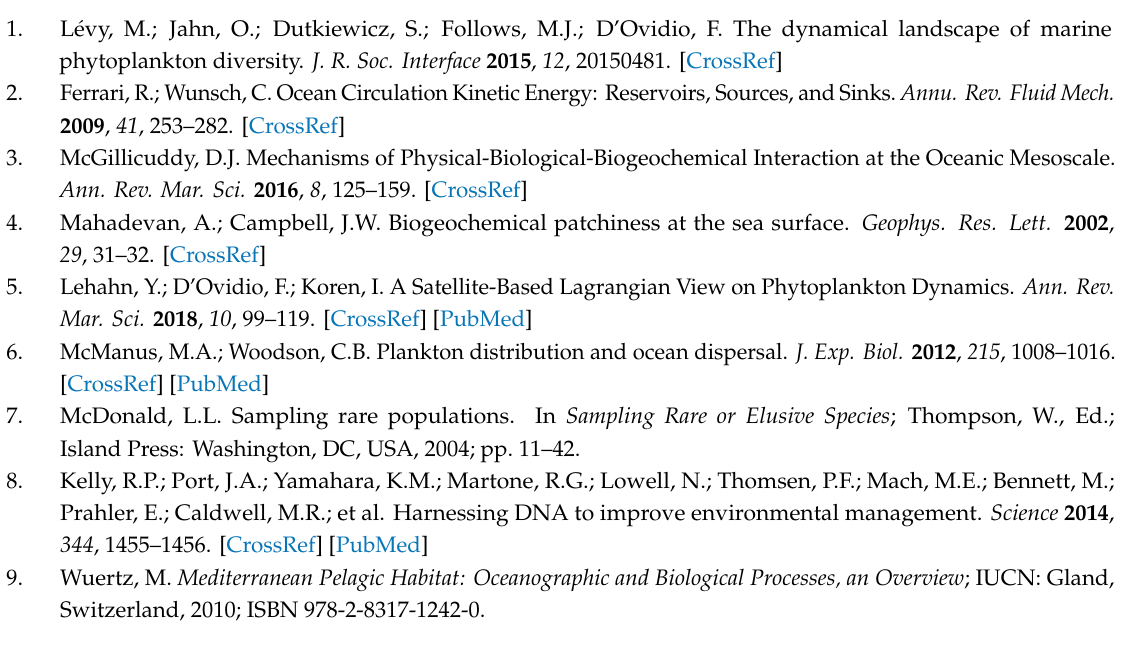
Table S1-Planktonic taxa surveyed at the diving site; Figure S1—(a) and (b) show respectively the wind rose of Ponza (2011–2015) and Gaeta (2007-present). Map (c) and (d) show respectively the mean distribution of SST and Salinity from 1987 to present; Figure S2-In the panel (a) is presented in descending order the distribution of SST during 9th–11th of April, during 12th–18th of April and during 19th–28th of April. In the panel (b) the polar scatter of wind indicates the direction (polar orientation) and intensity of wind (x-axis). In the panel (c) is presented in descending order the distribution of Salinity during 9th–11th of April, during 12th–18th of April and during 19th–28th of April; Figure S3-Taxa occurrence according to moon phase; Figure S4. The four sampled juvenile specimens of Trachipterus trachypterus from the central Tyrrhenian Sea (A–C), measurements are reported in Table S2; Table S2. Morphometric measurements of the four juvenile specimens of T. trachypterus reported in Figure S4 and collected in the central Tyrrhenian Sea; Plate I. Mating behaviour observed during the surveyed period (A) nereids epitokes mating close to the surface; (B) details of epitokes releasing eggs; Plate II. Mating behaviour observed during the surveyed period: (A) Idioteidae on a feather; (B) Sepiolidae; Plate III. Trophic interaction within plankton community, observed during the surveyed period: (A) Scyllaridae phyllosoma feeding on a salp, with detail of its peculiar interaction with jellyfish species as a floating support; (B) Phylliroe cfr. lichtensteinii feeding on a jellyfish; (C) Pelagia noctiluca feeding on a salp; Plate IV. Fish juvenile / larval stages recorded during the